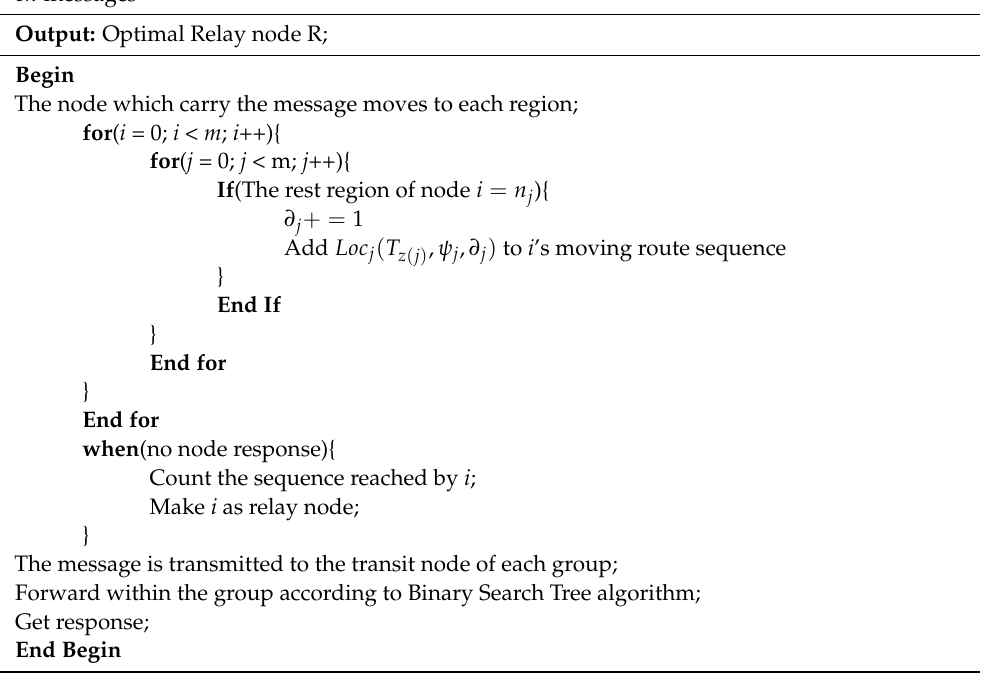
Algorithm 1. Inter-cluster message query algorithm based on the similarity of nodes’ mobile route location sequences